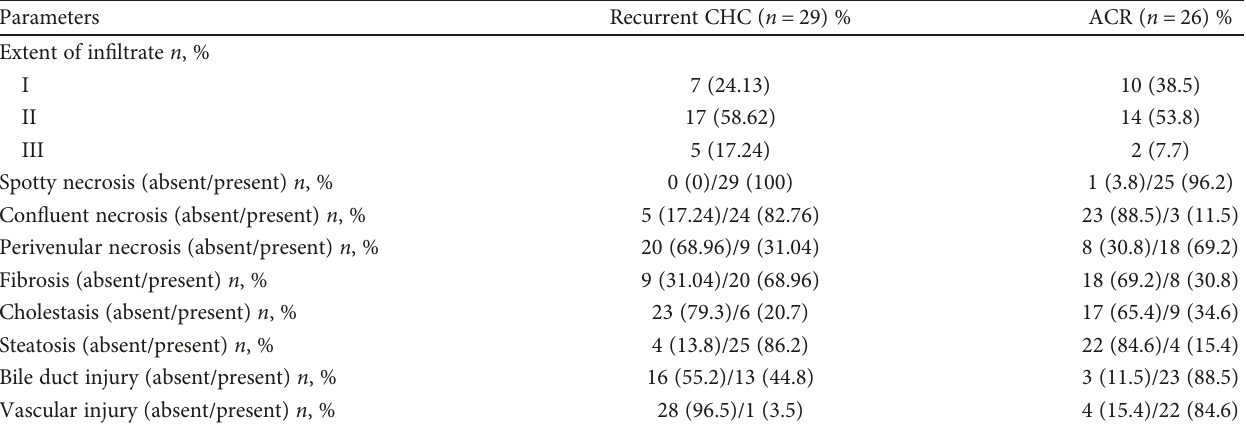
Table 2: Histopathological characteristics of patients with recurrent chronic hepatitis C (CHC) and acute cellular rejection (ACR). Parameters